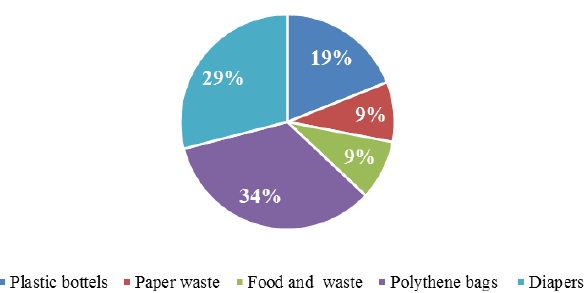
Fig. 6. Types of solid waste generated by tourist